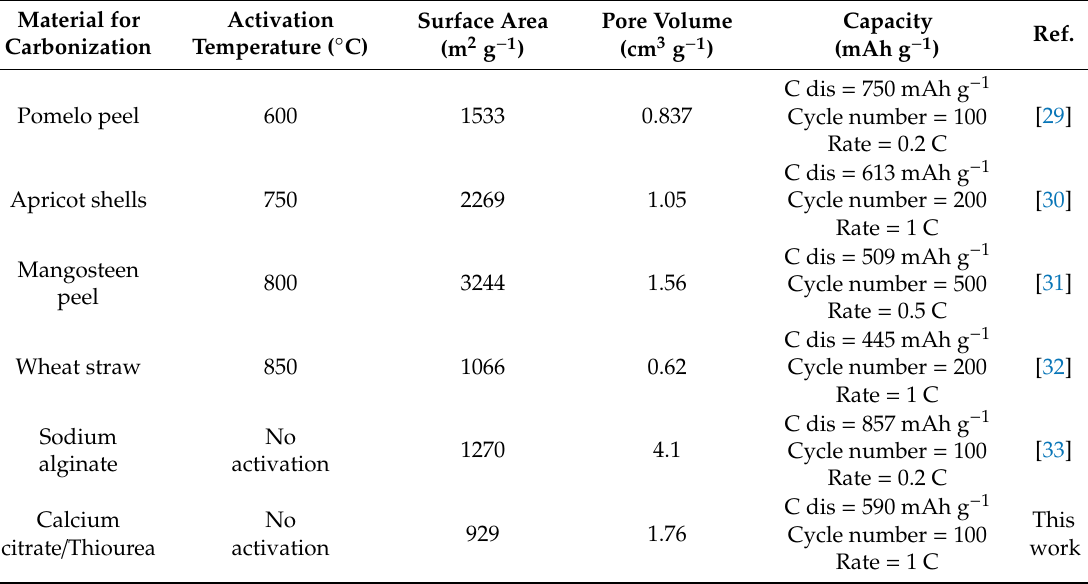
Table 2. Cathode materials and their properties for Li-S